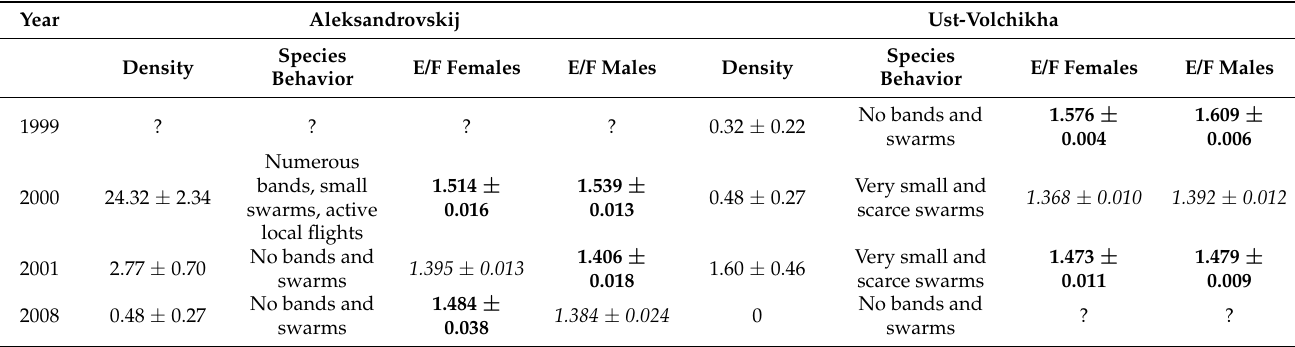
In bold—the average E/F ratios correspond to the intermediate (transiens) status of the local population; in italics—the solitarious status of the population; ?—no data for this